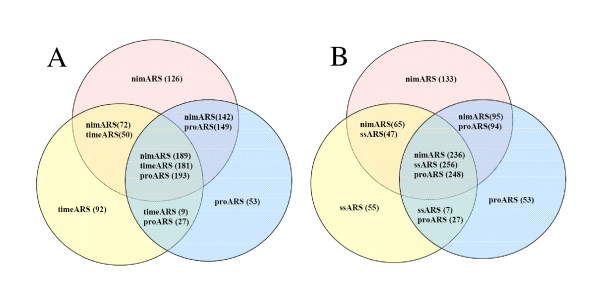
Venn diagrams showing overlap of data sets. A. nimARS, proARS [24] and timeARS [32]. B. nimARS, proARS and ssARS [34].